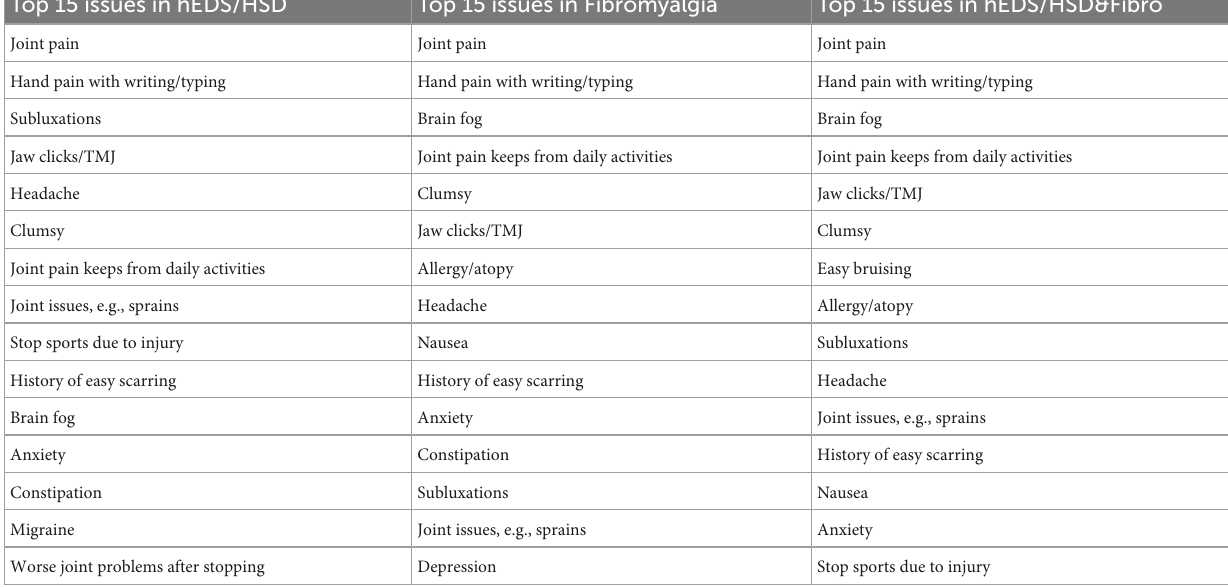
TABLE 8 Top 15 self-reported issues in patients with hEDS/HSD, Fibro or hEDS/HSD&Fibro in men and women. Top 15 issues in hEDS/HSD Top 15 issues in Fibromyalgia Top 15 issues in